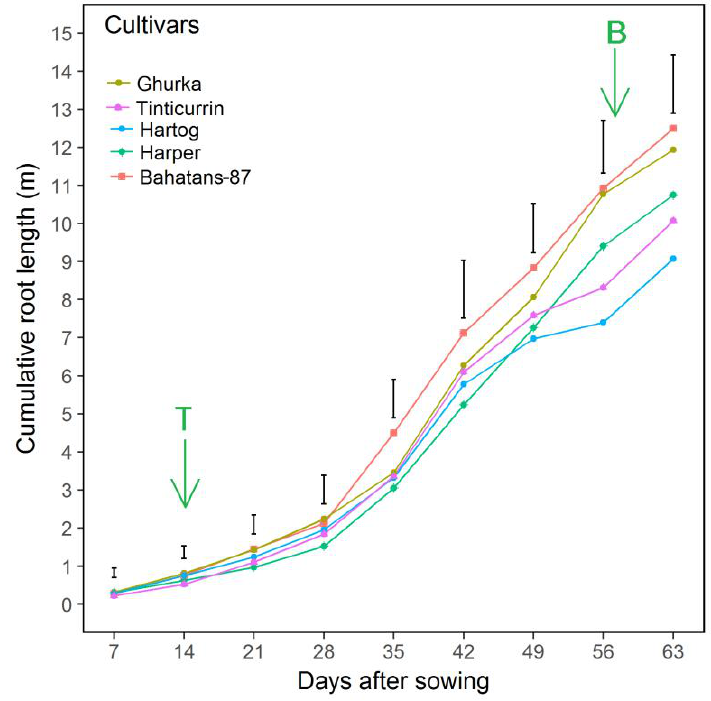
Figure 1. Cumulative visible root length measure non-invasively every 7 days by root mapping through the glass wall of each rhizobox from the time the plants were 7 to 63 days after sowing (DAS). Vertical bars represent LSD at p < 0.05. The time to tillering for the five cultivars is indicated by T and the time to booting for the cultivars Tinticurrin and Hartog is indicated by B. Time to booting for the Harper, Ghurka and Bahatans-87 cultivars is not indicated, as booting in these cultivars occurred at 85, 92 and 95 DAS, respectively. The vertical bars represent LSD at p < 0.05. Supplementary detail data on the cumulative visible root length, measured by root mapping through the glass wall of each rhizobox, is available in Table S2.